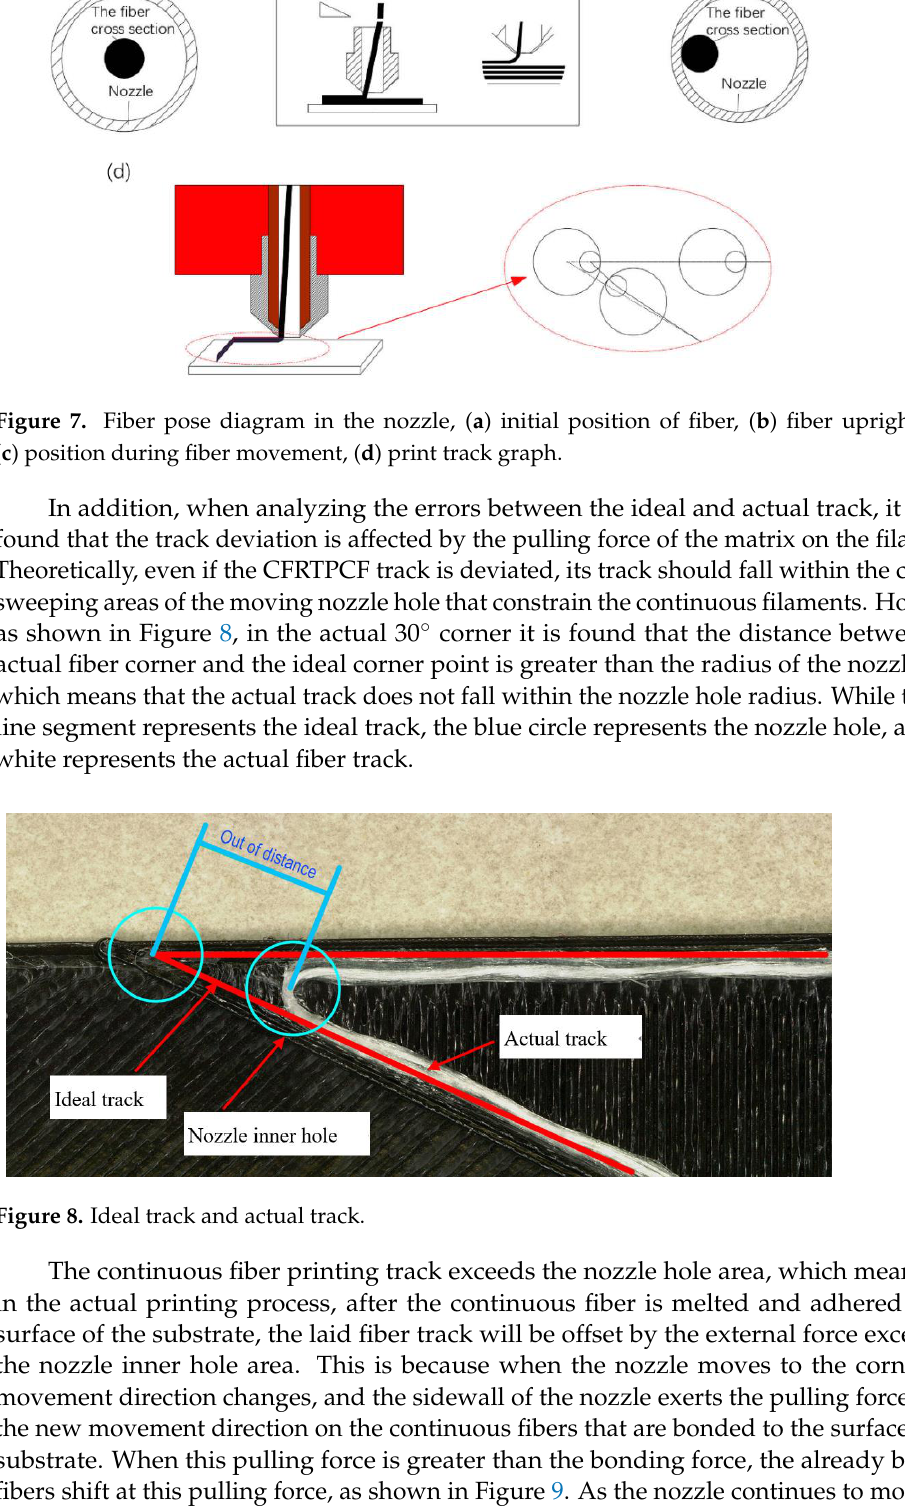
Figure 6. Actual track result, ( a ) void area change curve with angle, ( b ) schematic diagram of the minimum curvature R min at the corner changing with the angle.